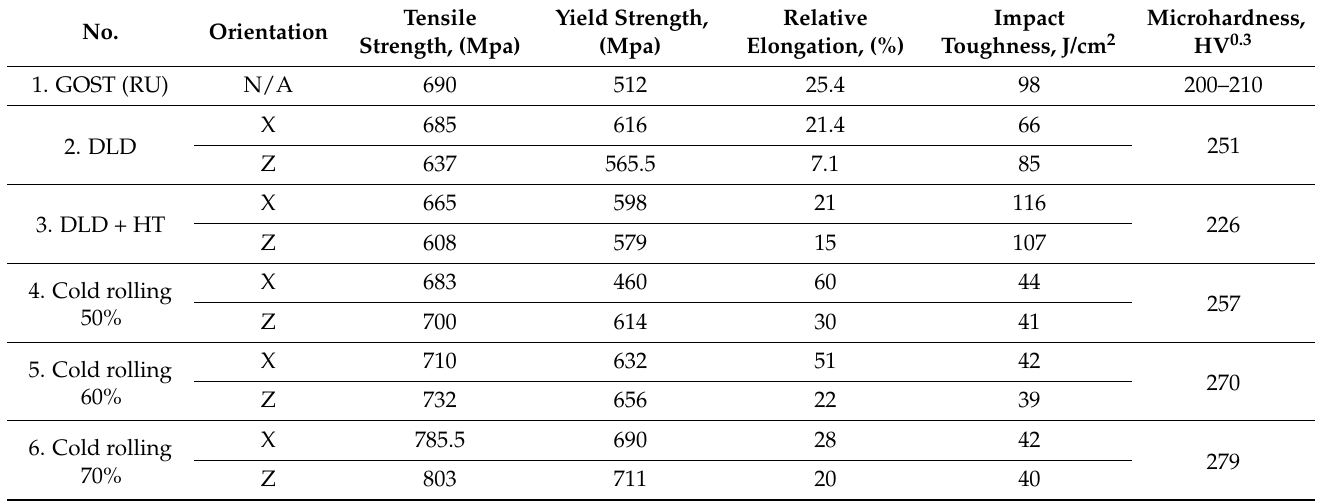
Table 3. Mechanical properties of steel